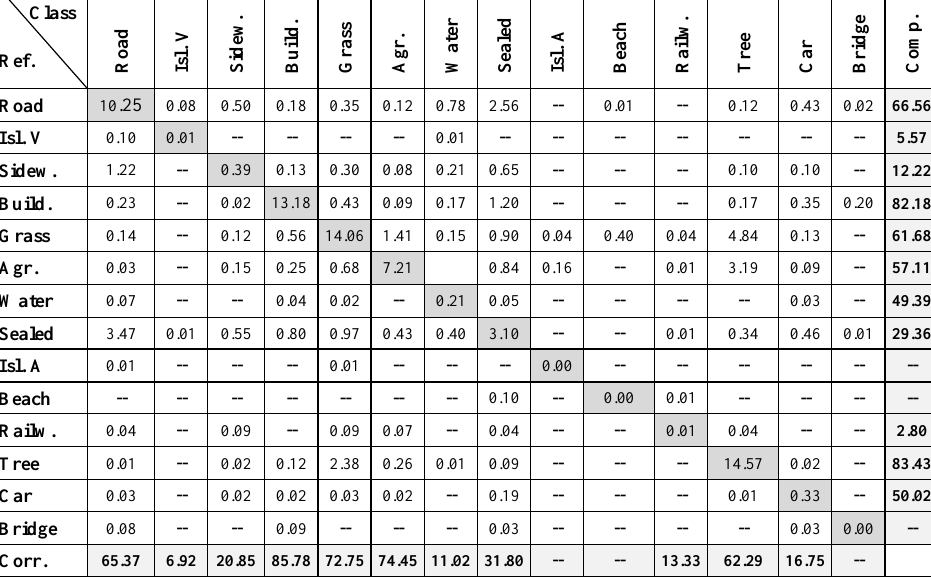
Table 2: Confusion matrix for the experiment using 14 classes without the car confidence feature. All values are given in [%]. Overall accuracy: 63.32%. Abbreviations: see caption of Table